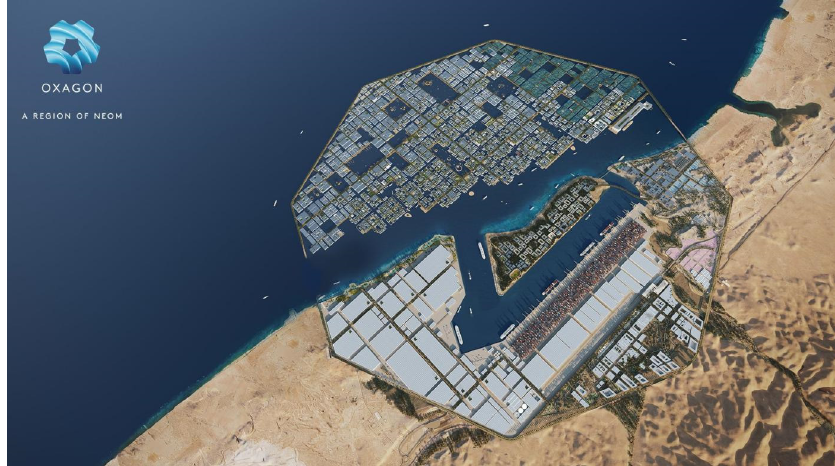
Figure 1. Proposed structure of Neom city.